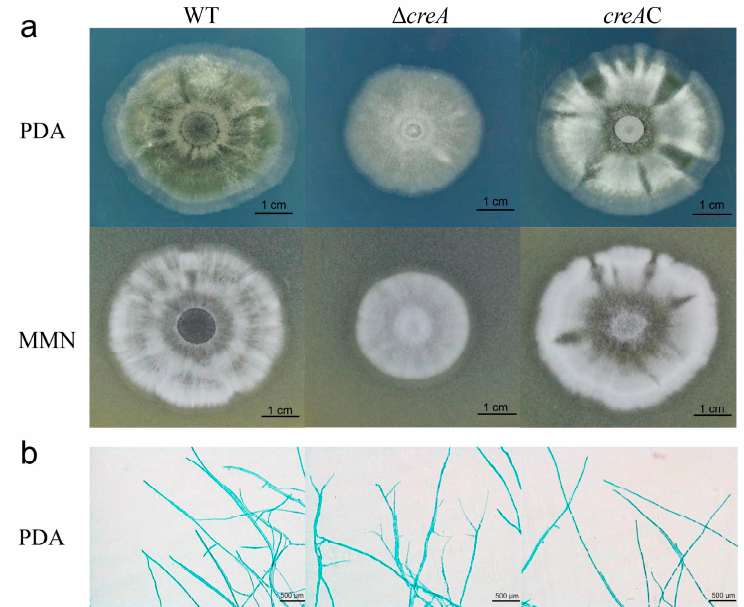
Figure 3. Characterization of the creA disruption mutant growth and hyphal morphology. ( a ) Colony growth and sporulation of the creA disruption mutant, creA complement strains, and the wild-type (WT) strain on modified Melin–Norkrans (MMN) and potato dextrose agar (PDA) plates at 42 °C for 3 days. ( b ) Hyphae observed under a microscope. All strains were grown on PDA plates at 42 °C for 24 h. creA C, creA complement strain.